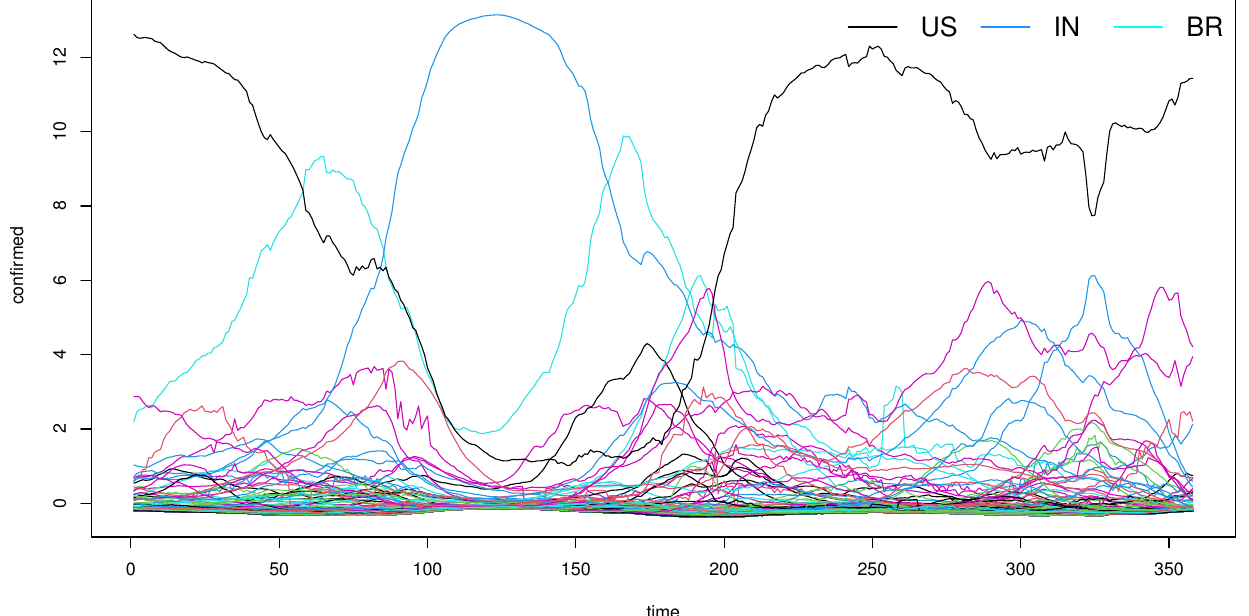
Figure A2. COVID-19 data in real data